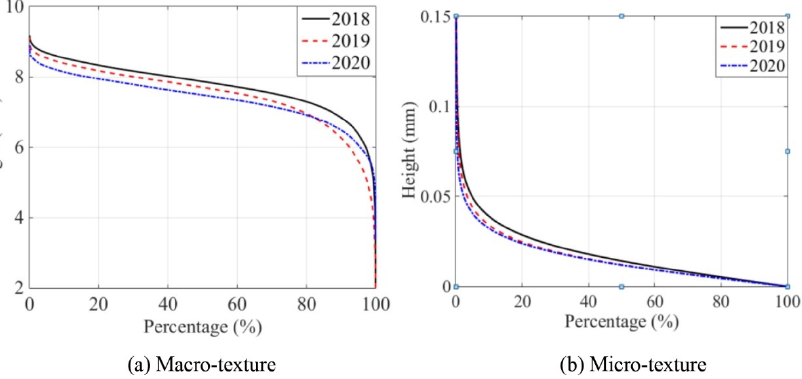
Figure 10. Cumulative height distribution curve of pavement macro- and micro-texture: ( a ) Macro − texture, and ( b ) Mi- cro − texture.